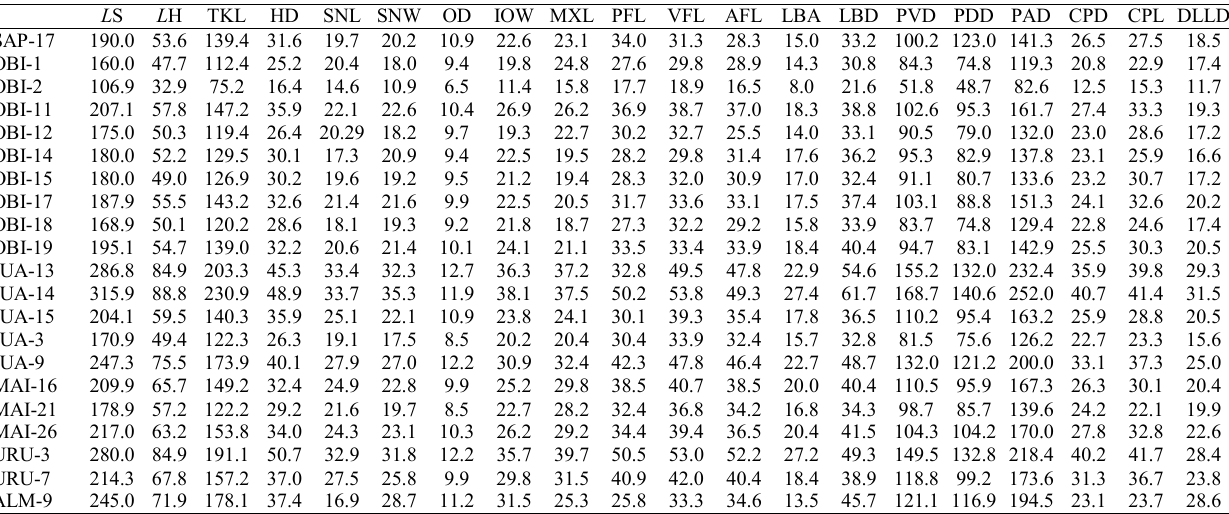
Table 2. Morphological measurements of Hoplias malabaricus from lower Amazon River. The measurement abbreviations are: standard length (LS); head length (LH); trunk length (TKL); head depth (HD); snout length (SNL); snout width (SNW); orbital diameter (OD); interorbital width (IOW); maxilla length (MXL); pectoral fin length (PFL); pelvic fin length (VFL); anal fin length (AFL); length of the base of the anal fin (LBA); length of the base of the dorsal fin (LBD); pre-pelvic distance (PVD); pre-dorsal distance (PDD); pre-anal distance (PAD); caudal peduncle depth (CPD); caudal peduncle length (CPL); distance from the lateral line to base of dorsal fin (DLLD). Measures taken in